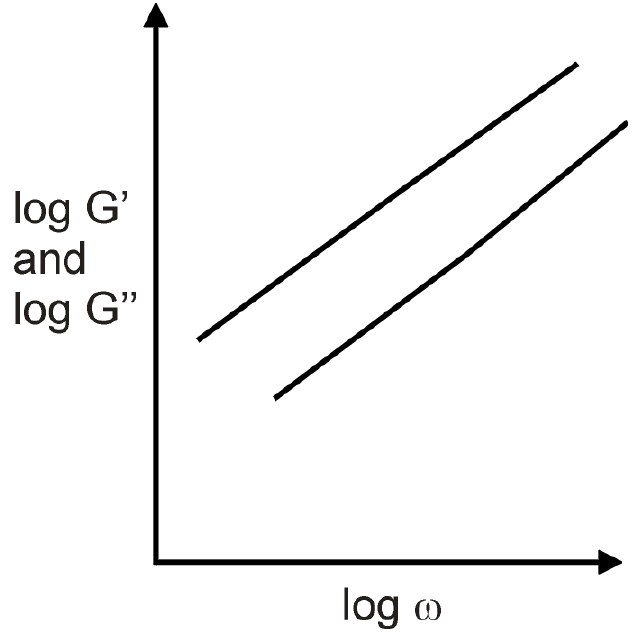
FIGURE 9. Mechanical spectra showing the common power-law dependence of G ′ and G ″ at the gel